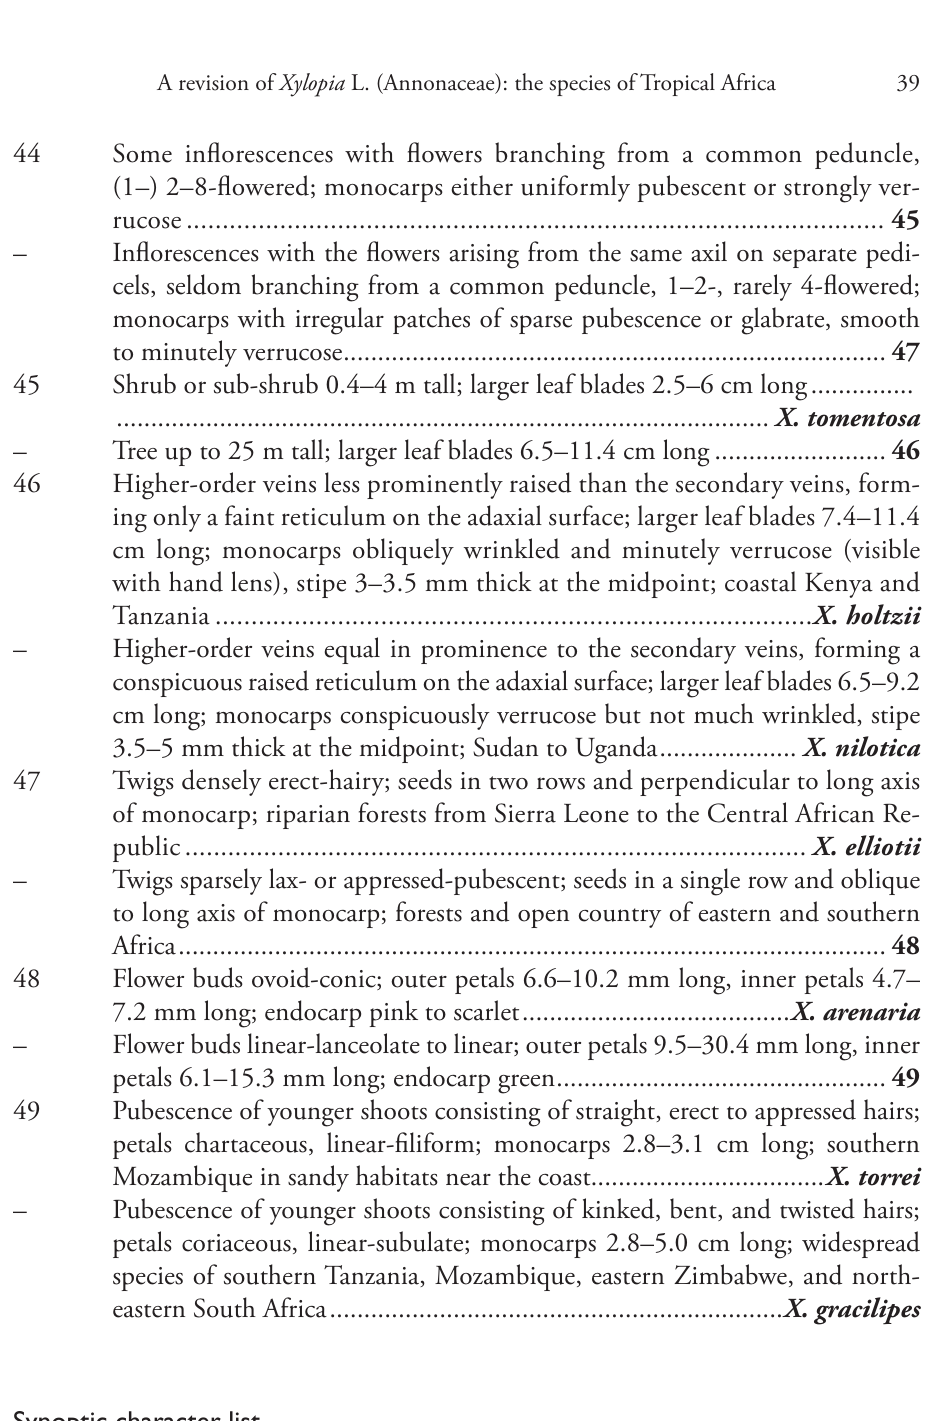
Synoptic character list Below are characters that are relatively noticeable and occur in only a small number of species. Species for which a character is unknown are not included, even when a prediction could probably be made. Not all species are included. Species are listed in alphabetical